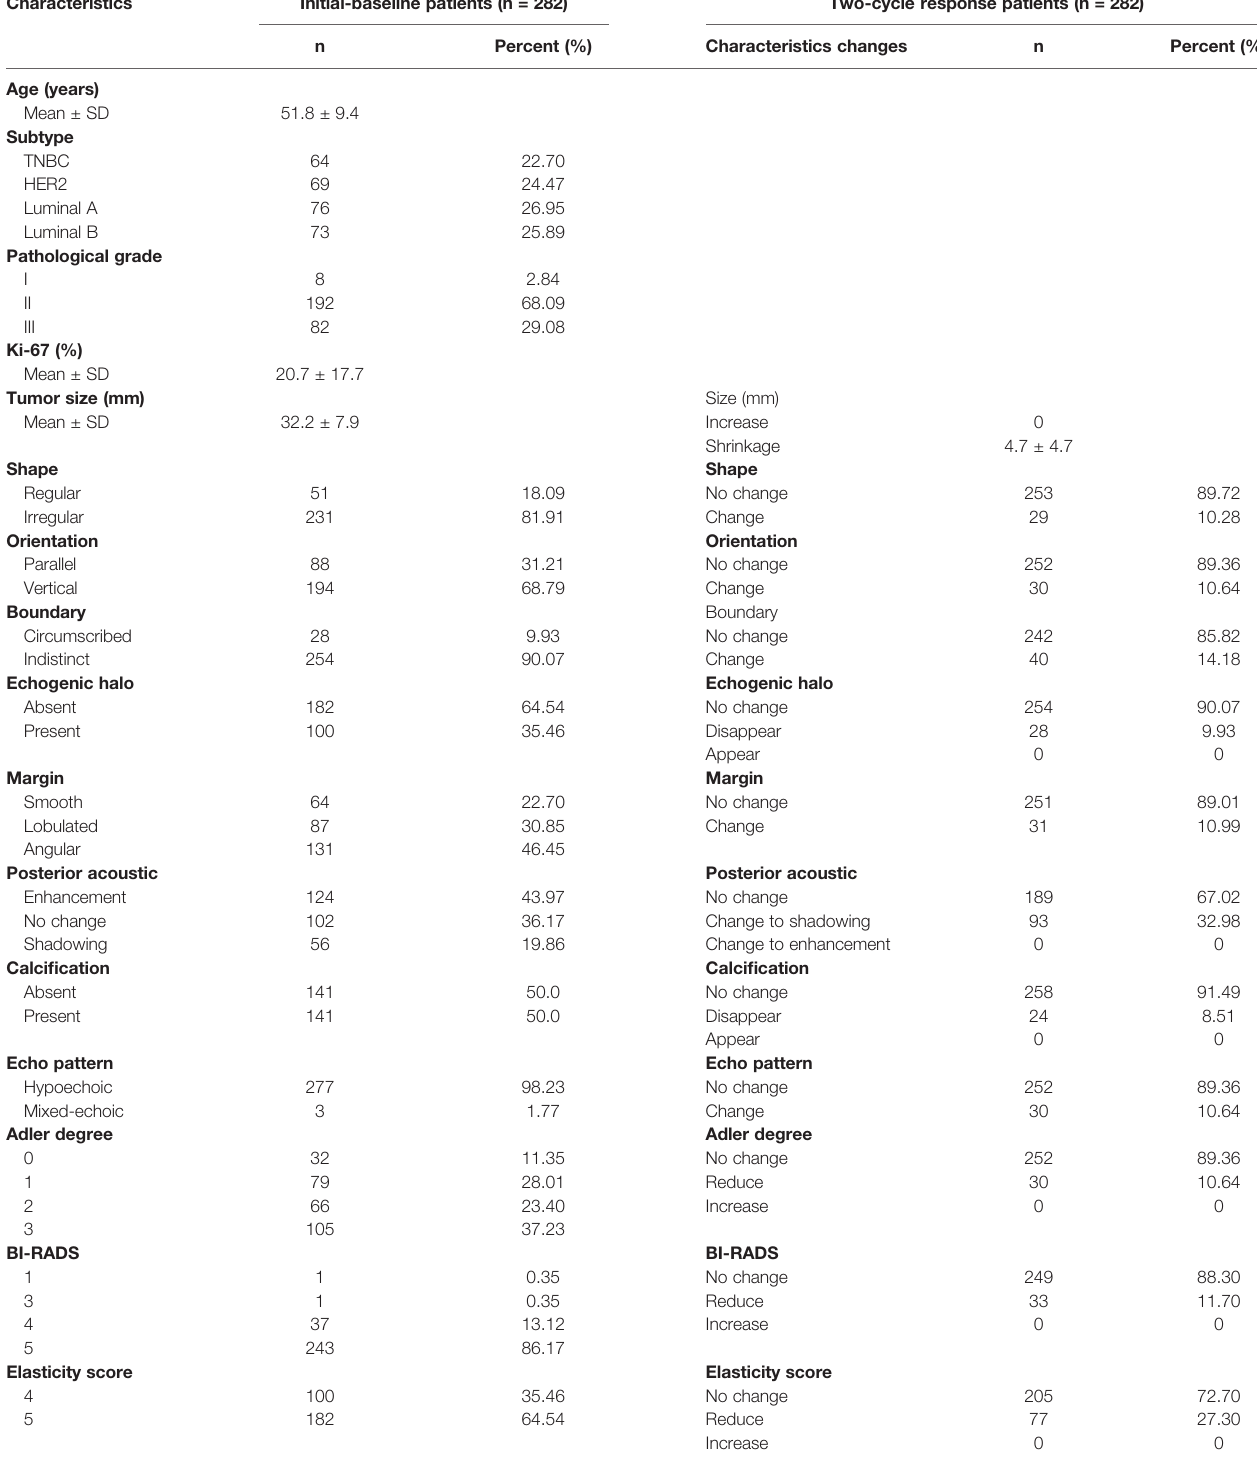
TABLE 1 | Ultrasound and clinicopathological characteristics of patients of initial-baseline patients and two-cycle response patients.